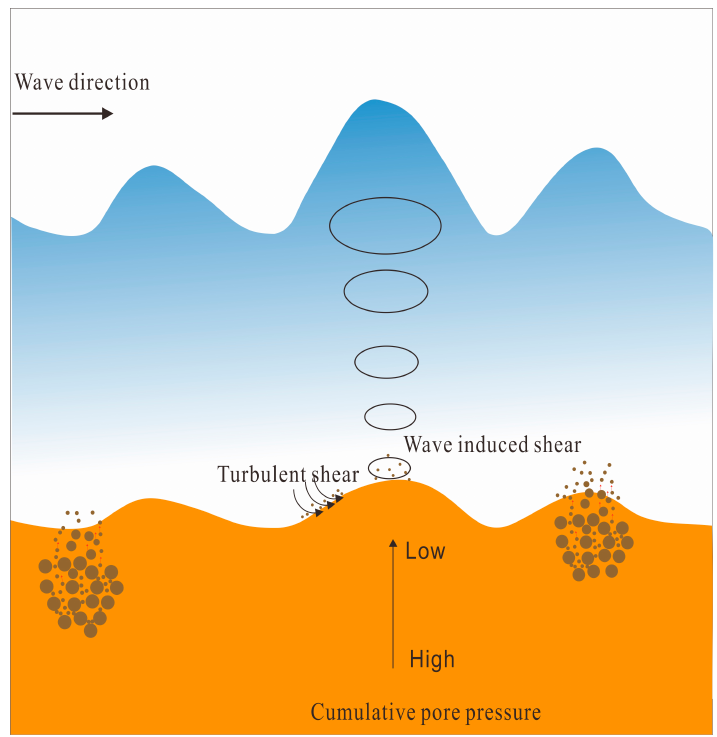
Figure 13. Sketch map showing the dynamic response of liquefied soil to random waves.